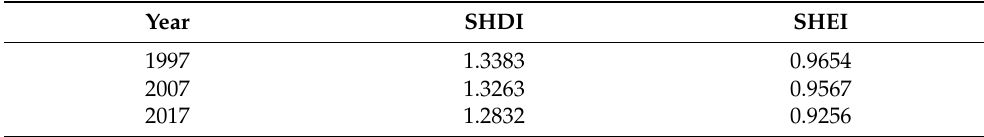
Table 5. Landscape-level spatial metrics for the MMNL